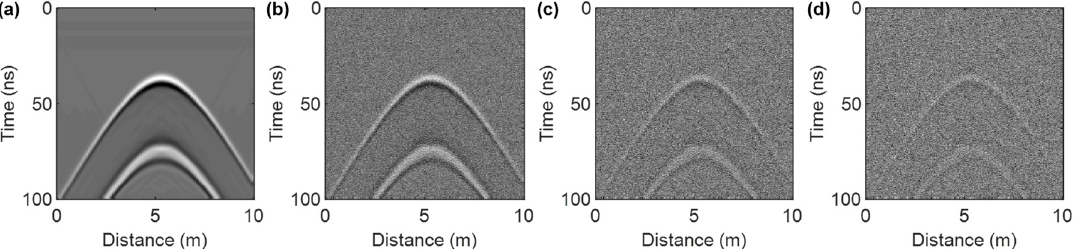
Figure 6. The comparison of radar profiles with different parameter α 2 . ( a ) The normalized radargram with α 2 = 0. ( b ) α 2 = 1. ( c ) α 2 = 3. ( d ) α 2 = 5.